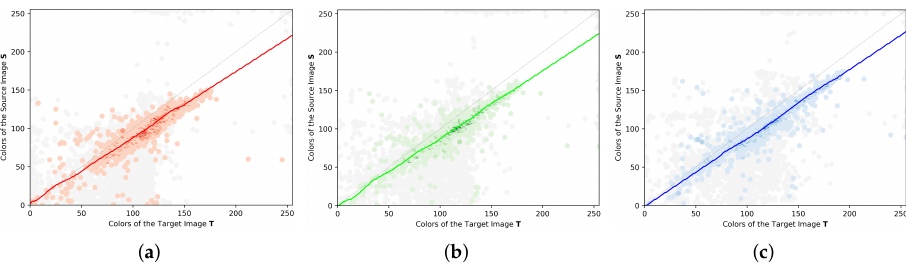
Figure 7. Example of the estimation of three CSVR Functions. ( a ) CMF estimation for the red channel represented by the red curve, ( b ) CMF estimation for the green channel represented by the green curve and ( c ) CMF estimation for the blue channel represented by the blue curve. The gray dots represent the discarded pairwise